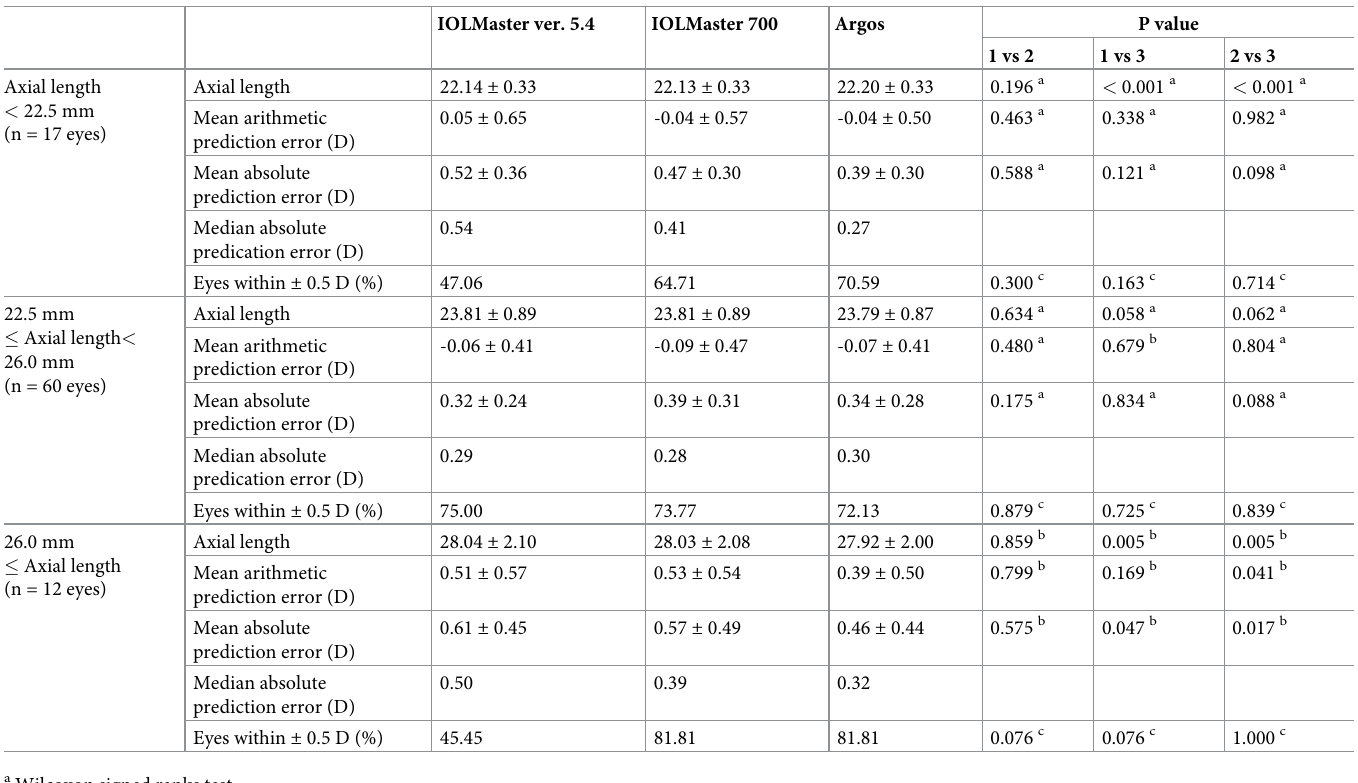
Table 4. Comparison of postoperative refractive errors according to axial length